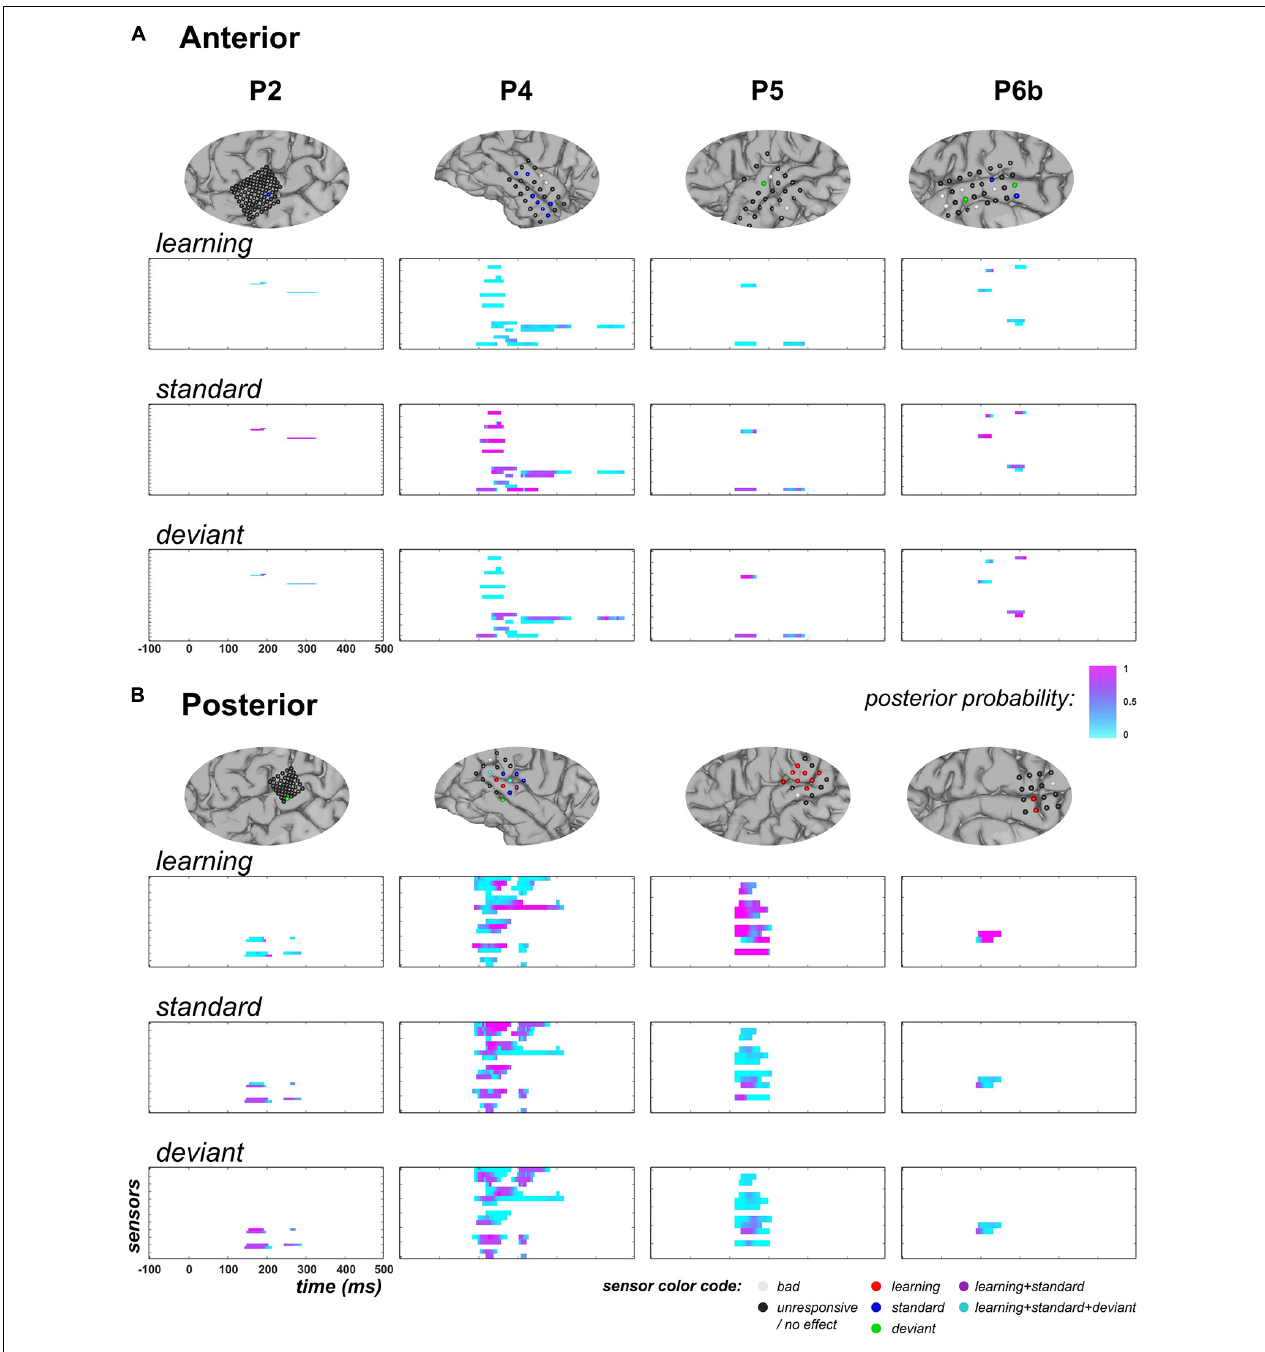
FIGURE 6 | GLM findings at temporal electrodes (across contexts, UC and PC). (A) Anterior overlay. Top row: for each subject (columns), zoomed view of cortical mesh with anterior temporal electrodes (following the clustering depicted in blue in Figure 4C ). Electrodes exhibiting a posterior probability larger than 0.9 in the 50–250 ms time window (at least one sample) for one or multiple regressors are colored following the code provided at the bottom right of the figure. Rows 2 to 4: family-level inference for regressor X BS dyn , X std static , and X dev static , respectively. Each graph represents the posterior probability of family X ∗ ∗ = ON, measured at each peri-stimulus sample. (B) Posterior overlay. Same display, with electrodes in posterior clusters (purple cluster in Figure 4C ).